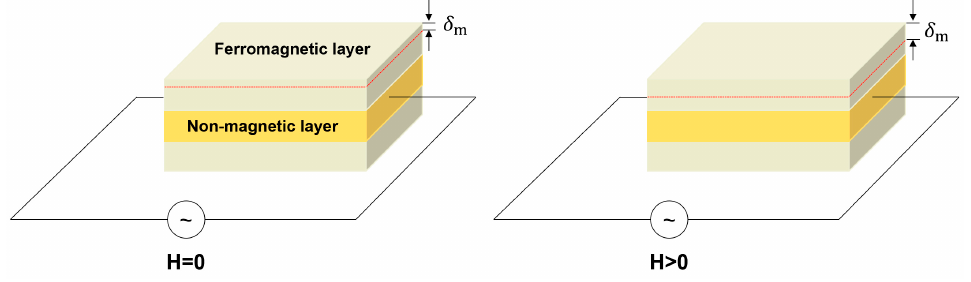
Figure 12. Working principles of MI sensor.